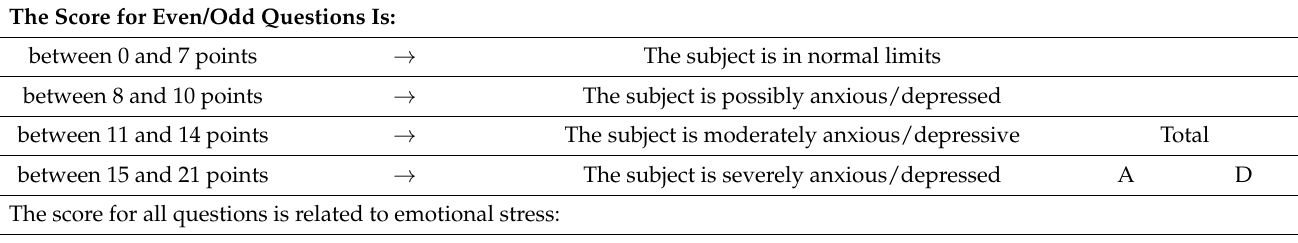
Table 1. Rating of responses to the HADS Scale, for anxiety or